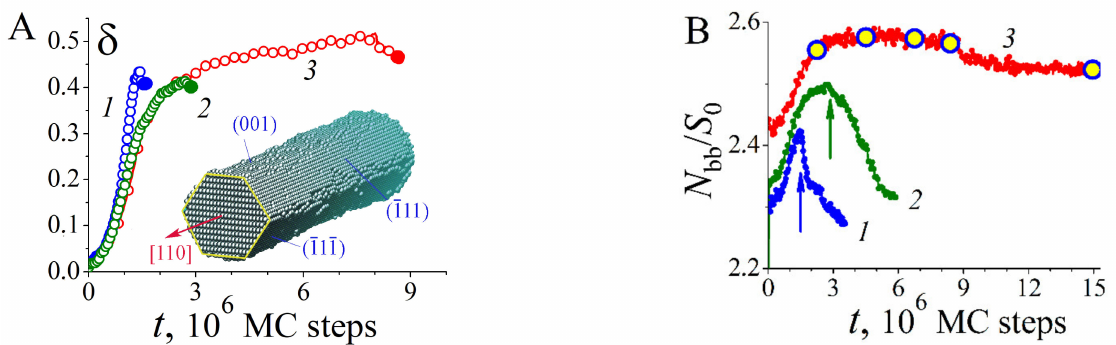
Figure 7. Dynamics of morphology characteristics of nanowires with (110) orientation under stim- ulation of atomic surface diffusion. α = 1, p = 0.825: ( A ) change in the level of modulation of the cross-section of nanowires, ( t ) , of different radii. For curves 1, 2, 3— r nw = 15.5, L = 700; r nw = 17.5, L = 700; and r nw = 20.5, L = 500, respectively. Color circles mark the time moments of the first ruptures. The inset shows the typical shape of a nanowire with (110) orientation established at the initial stage of its transformation; ( B ) change in time of the number of broken bonds on the surface of nanowires for the same parameters. S 0 is the side surface area of the nanowire in dimensionless units in the initial state. The arrows indicate the moments of the first ruptures in the nanowires. The circles on curve 3 mark the moments of time for which in Figure 8C the shapes of the thickest nanowire are